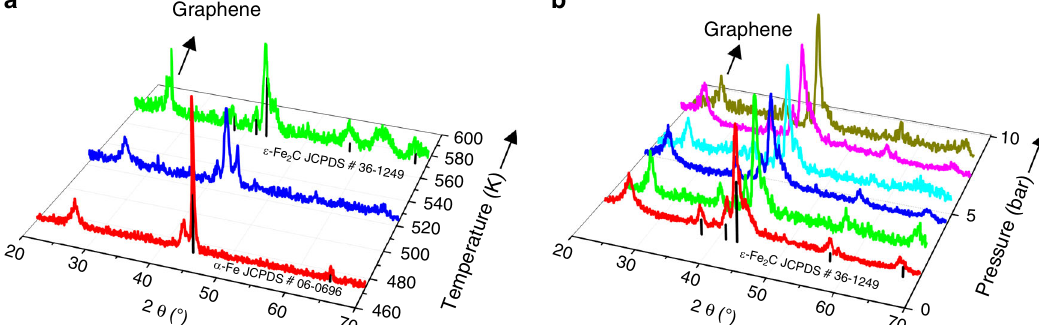
Fig. 3 XRD patterns for θ -Fe 3 C@graphene samples. a θ -Fe 3 C@graphene samples reduction under fl owing H 2 at 623 K for 3 h, and then treated under syngas (H 2 /CO = 1) at different temperature. b θ -Fe 3 C@graphene samples reduction under fl owing H 2 at 623 K for 3 h, and then treated under different CO pressure at 573